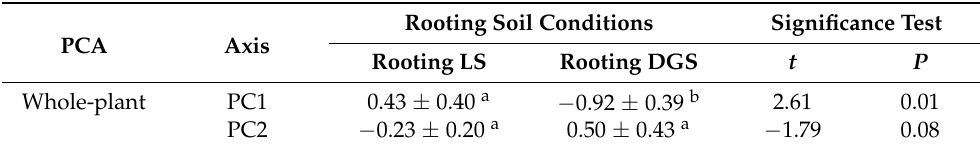
Different lowercase letters in the same row indicate significant differences among species ( p < 0.05).